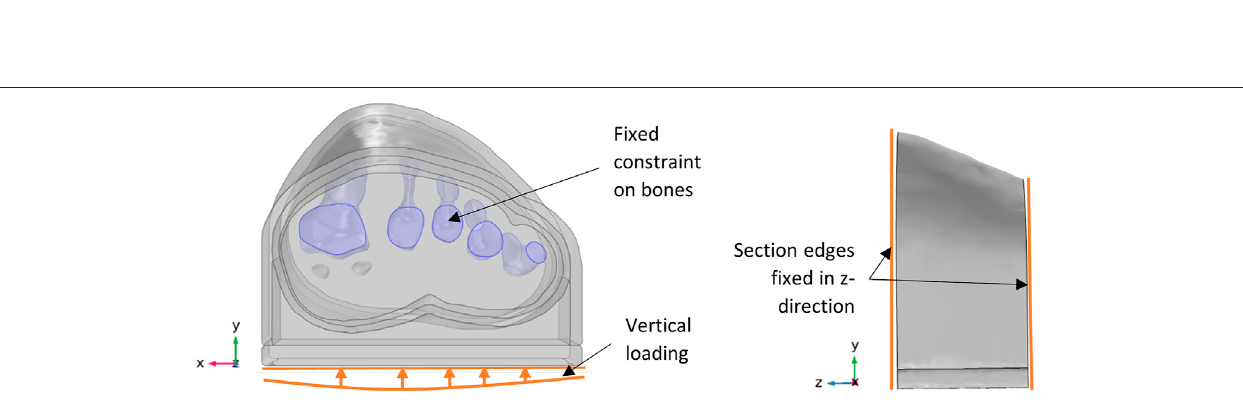
FIGURE1|(A) Segmentationofbones,skin,softtissuefromP3MRI,withadditionofsock,shoeupper,orthosis,shoesole,indicatingminimumorthosisdepth(1.) (B) Morphological measurements for P3 showing sesamoids in a normal position, with 2. Lateral distance from MH1 edge to sesamoid, 3. MH1 width, 4. Tissue depth under MH1 (C) P1 MRI showing example of sesamoids in a displaced position.